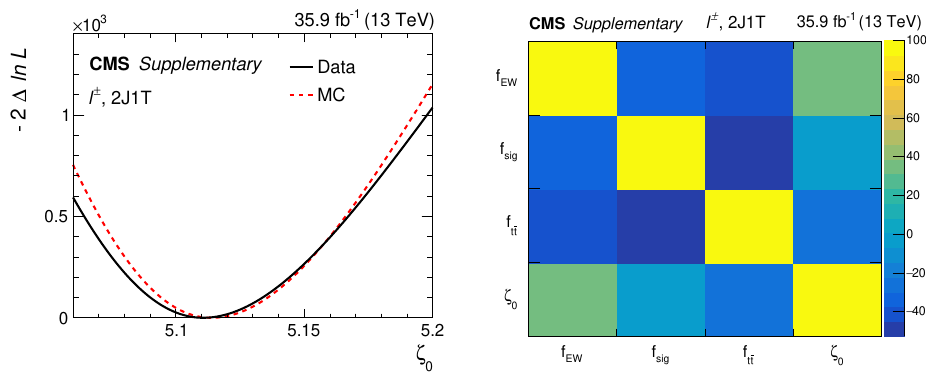
Figure 14 . Scan of the profile likelihood ratio as a function of the POI for the parametric fit model used in the l ± final state of the 2J1T category in data and simulated events (left). Correlations in % among the POI and nuisance parameters corresponding to the fit to data for the l ± final state of the 2J1T category